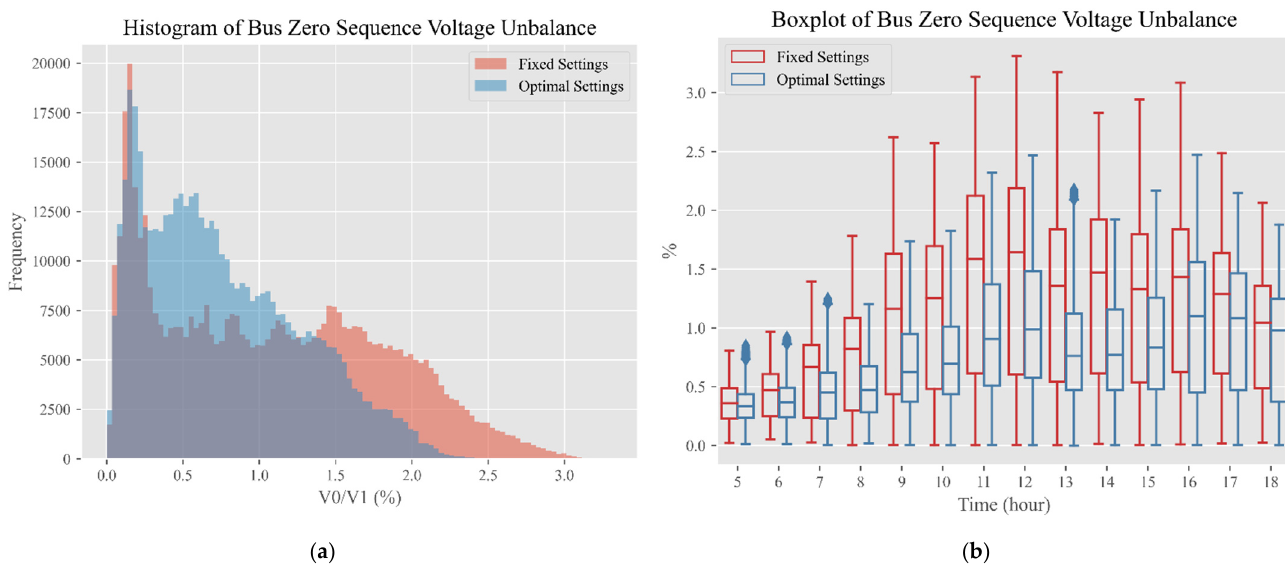
Figure 11. Zero sequence voltage unbalance: ( a ) Histogram; ( b ) Boxplot.